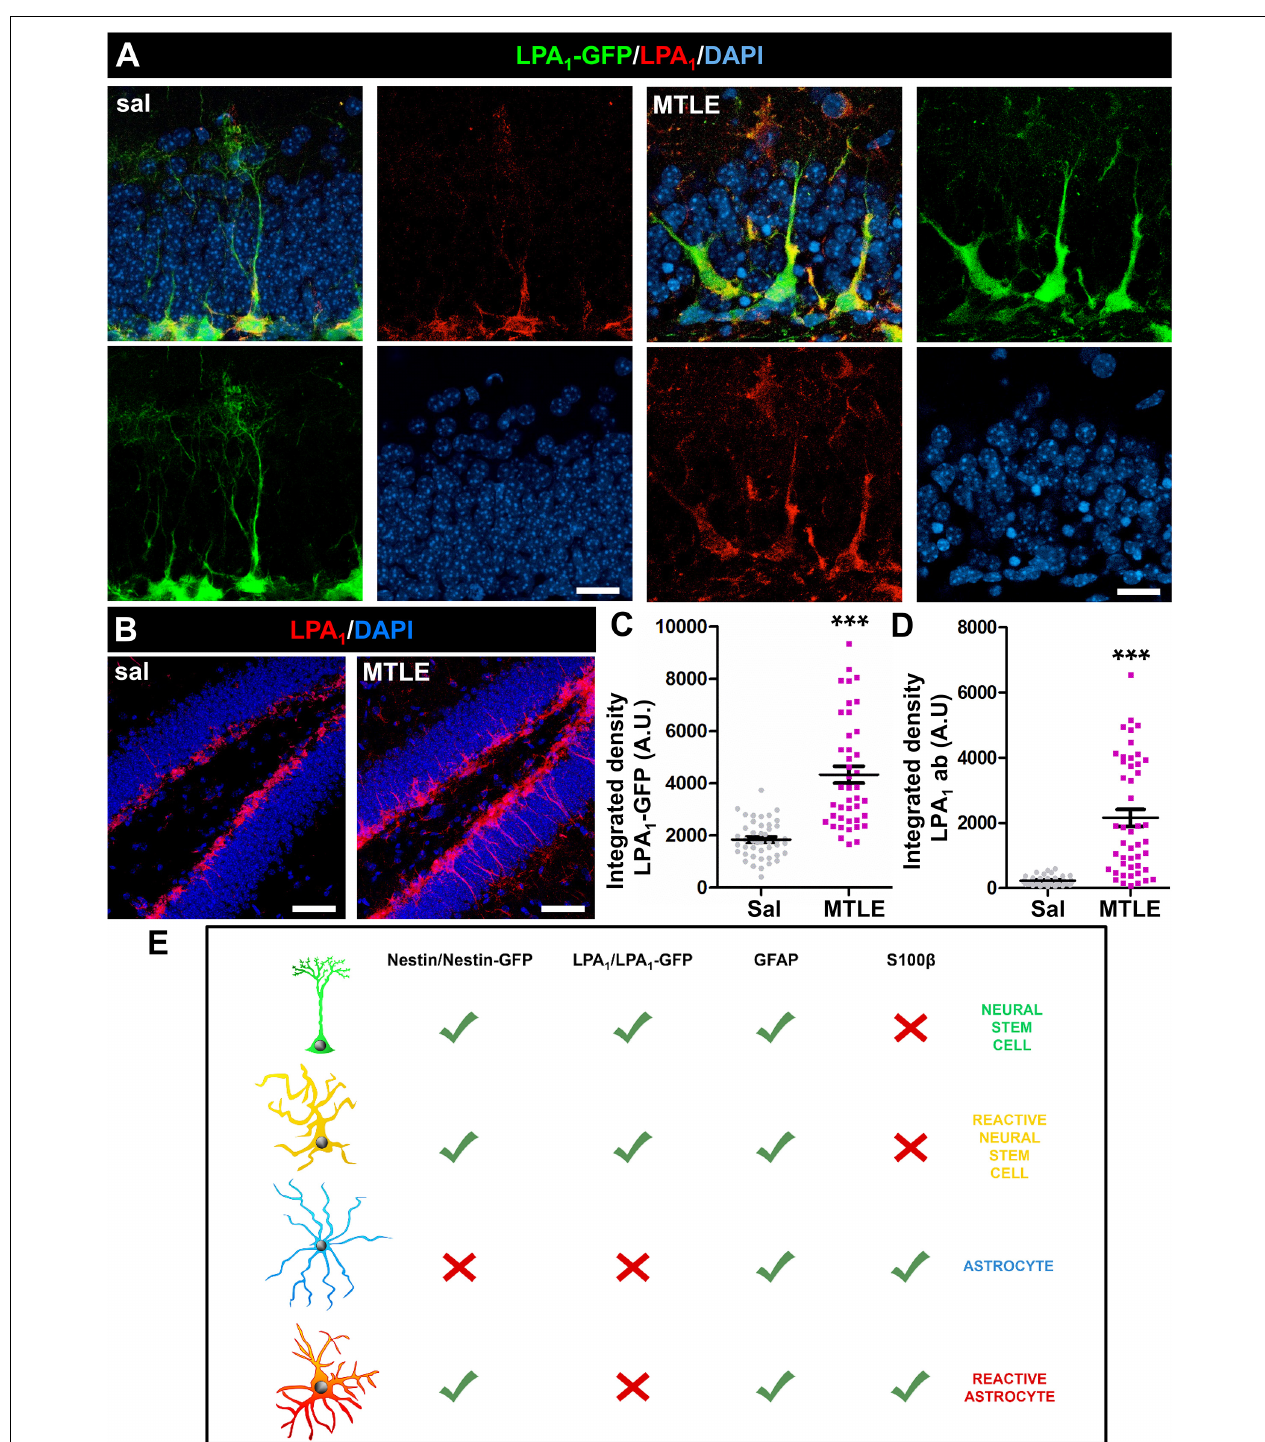
FIGURE 3 | Neural stem cells in sal-injected ( A , left) and React-NSCs in MTLE LPA 1 -GFP mice ( B , right) express LPA 1 (3 days after surgery) as demonstrated by immunostaining with anti-LPA 1 antibody. No other cell types were labeled with either LPA 1 -GFP or anti-LPA 1 antibody in control or MTLE mice (B) . The expression of LPA 1 -GFP (C) or LPA 1 (D) was significantly increased in MTLE-induced React-NSCs compared to control NSCs as measured by the integrated density of the fluorescent signal. (E) shows the combination of biomarker expression that can be used to differentially identify NSCs, React-NSCs, astrocytes, and RAs. Scale bar is 10 µ m in (A) and 50 in µ m (B) . Data were analyzed by a Mann-Whitney U test. Graphs show individual data and mean ± SEM. *** p ≤ 0.001.